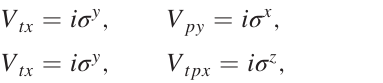
TABLE II. Symmetry fractionalization and twist factors for the fermionic and bosonic spinon and the vison in the phase Z 2 spin liquid with current-loop order. By comparing with the result in Ref. [22], we are able to verify the equivalent of C